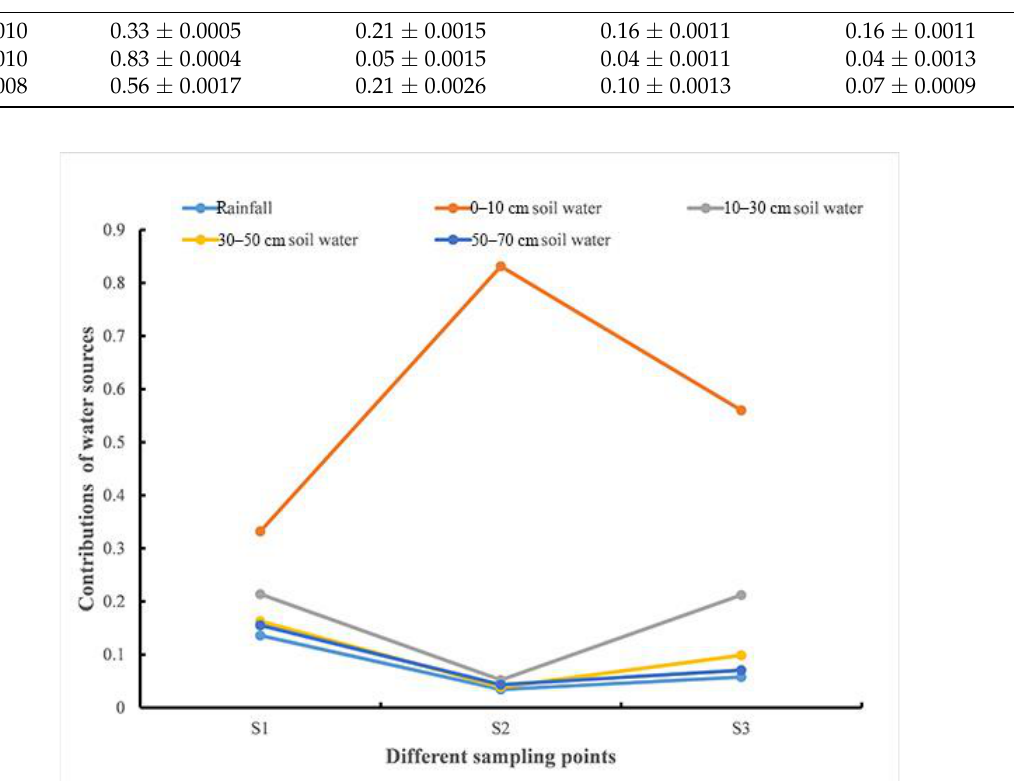
Table 1. The contributions of various water sources to Cynanchum sibiricum (Mean ± SE (Standard Error)). Rainfall